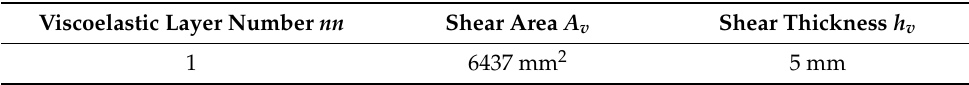
Table 1. Size of the viscoelastic